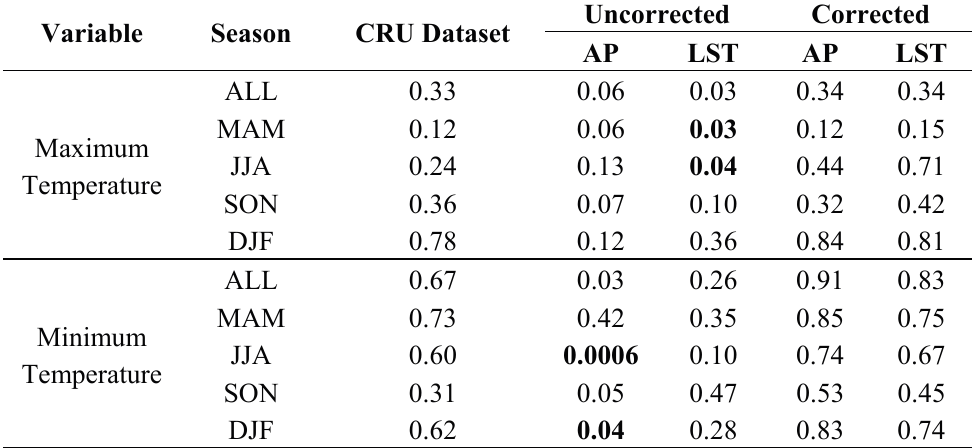
Table 3. Test statistics for one-way ANOVA testing differences between elevation classes of MAE values between ASOS observation data vs. the CRU dataset and monthly air temperature estimates with or without the correction using the CRU data. Values in bold indicate that there is a significant difference at the 95% confidence